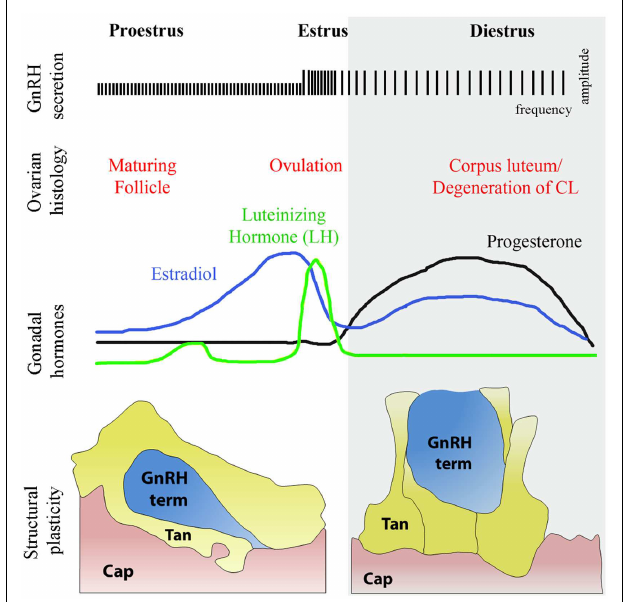
diestrus and proestrus .The schematic highlights the causal relationships during the different phases of the ovulatory cycle with changes respectively in GnRH secretion, ovarian histology, and circulating sex hormones levels. Changes in circulating gonadal steroids are responsible for the neuro/glial structural plasticity of the median eminence. During proestrus, GnRH nerve endings (blue) sprout toward the basal lamina delineating the pericapillary space (pink, Cap), with which they eventually make direct contact, while tanycytes retract. In diestrus, under conditions of low gonadotropin output, GnRH-secreting axon terminals are distant from the pericapillary space and tanycytes enwrap GnRH nerve endings, thus impairing access of the neurohormone to the pituitary portal